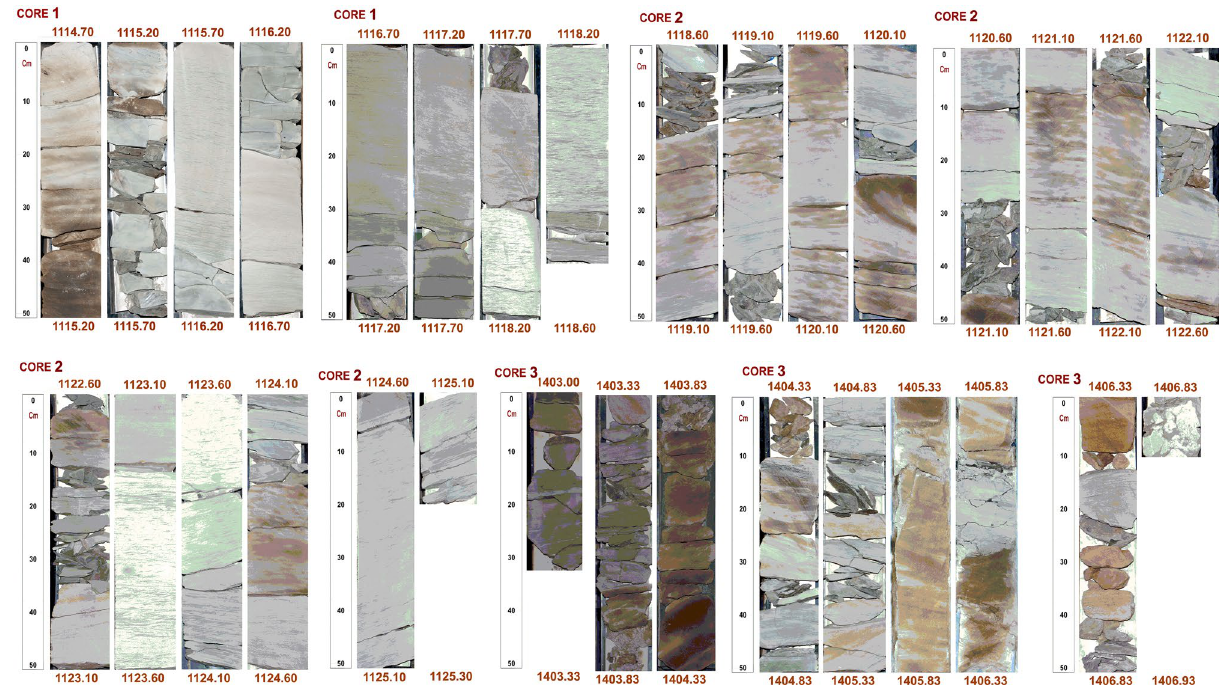
Figure 5. Conventional cores photos showing the studied core form Keyi N-A